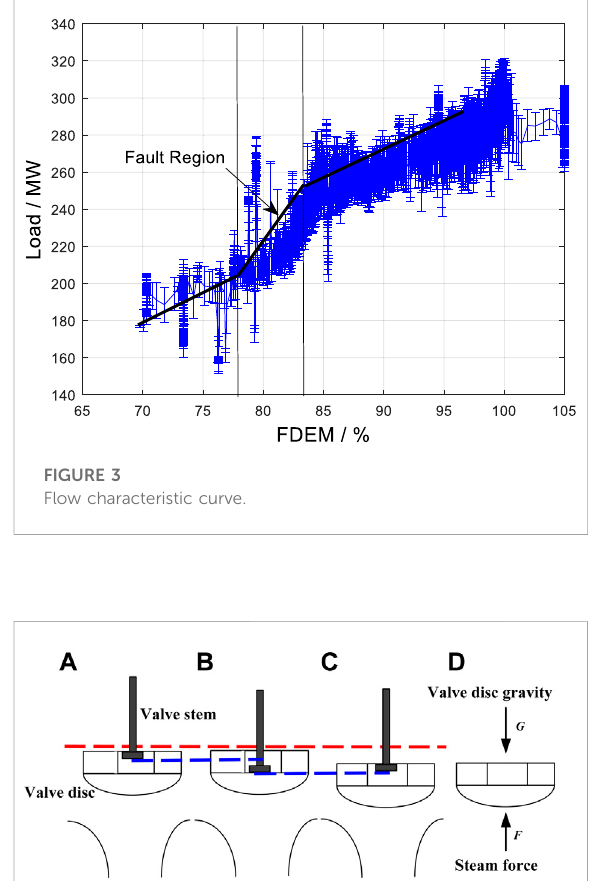
FIGURE 4 Schematic of actuator failure. (A) Normal state (B) valve disc raised (C) valve disc dropped (D) force